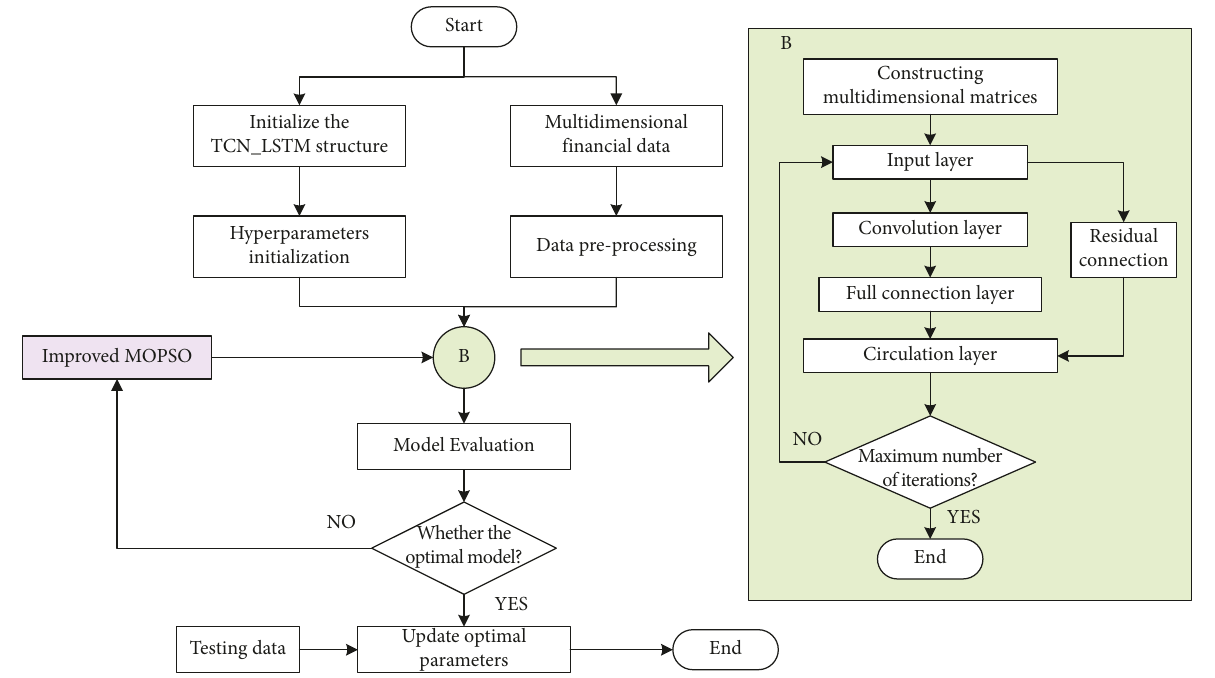
Figure 7: Overall flow of the prediction model. Table 1: Description of evaluation